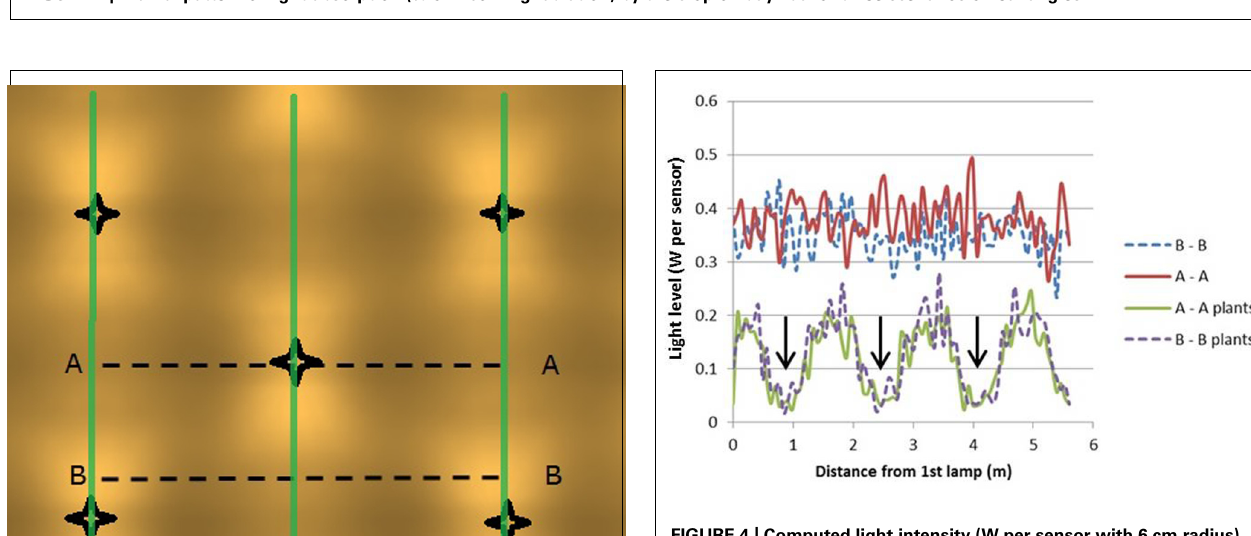
FIGURE 2 | Diurnal pattern of light absorption (% of incoming radiation) by the crop on day 180 for three scenarios of leaf angles.